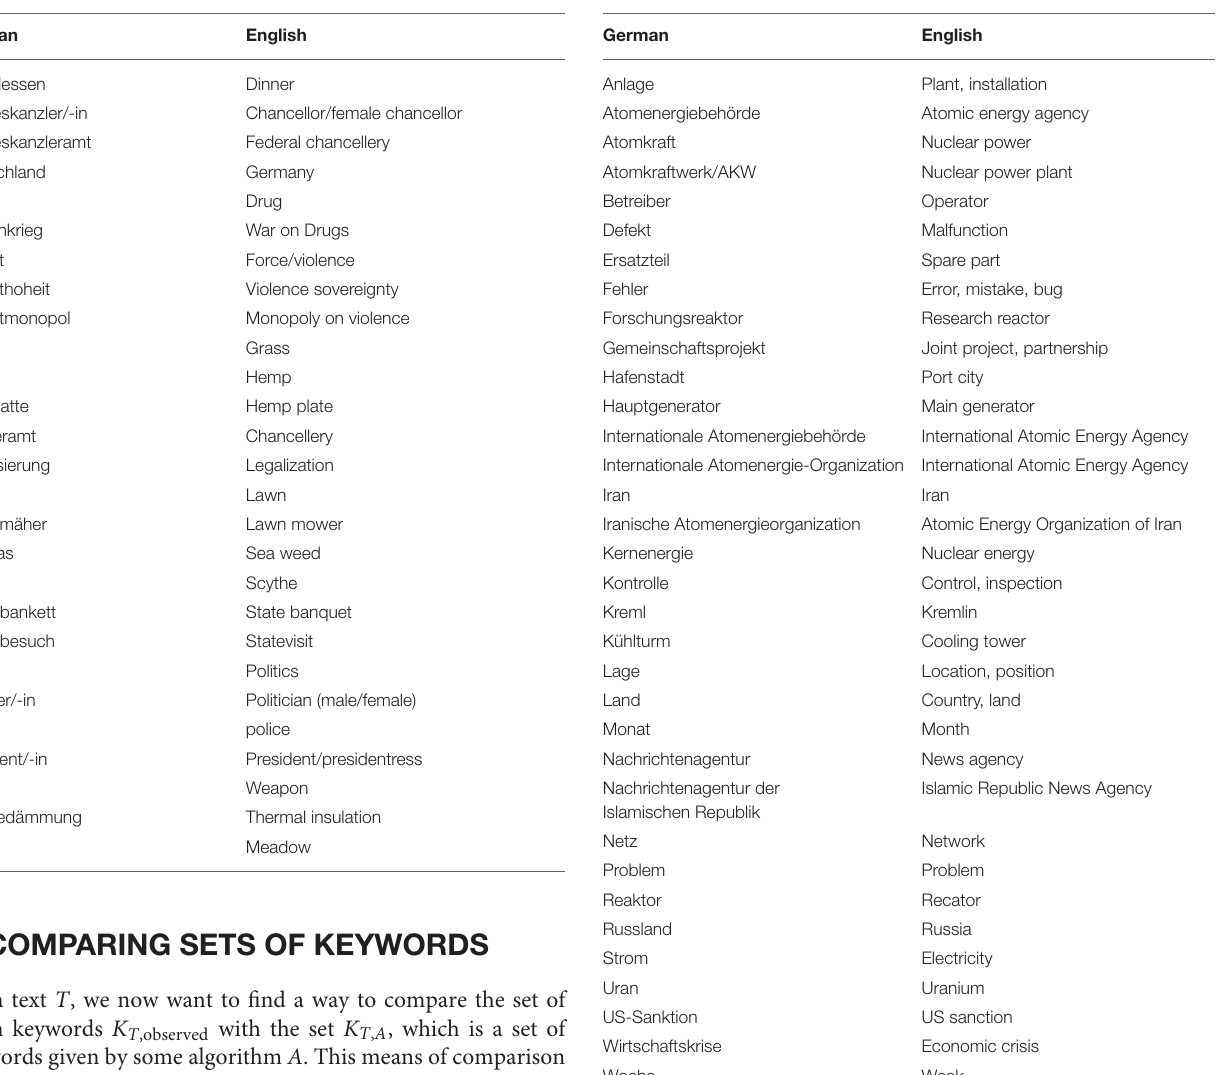
TABLE 1 | Translation for the terms in the Figure 2 . TABLE 2 | Translation for the terms in the Figure 3